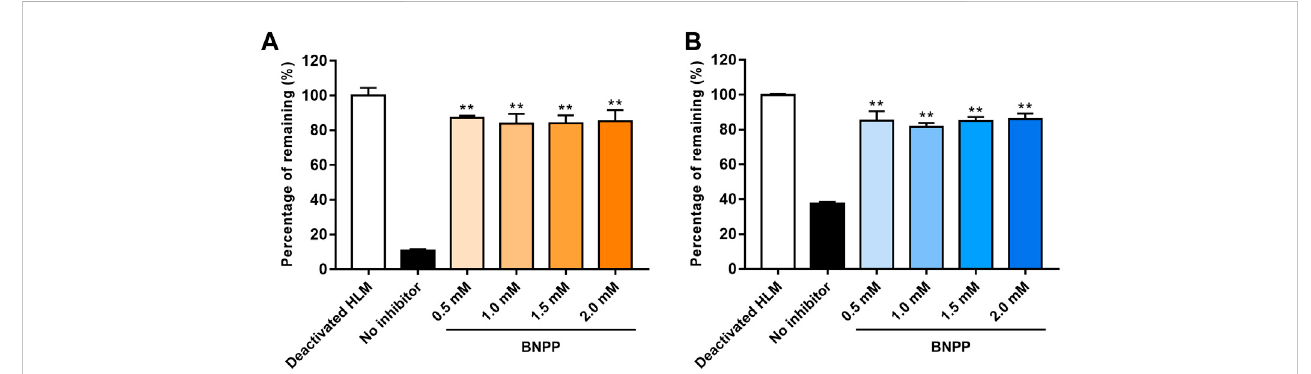
FIGURE 4 In fl uenceofBNPPonEA (A) andEB (B) stabilityinHLMsintheabsenceofNADPH.IncubationwithdeactivatedHLMswasperformedfornegativecontrols (100% remained). Incubation of HLMs without inhibition was performed for positive control. Signi fi cant differences from positivecontrol were analyzed using the t -test. * p < 0.05, ** p < 0.01 (mean ± SD; n =